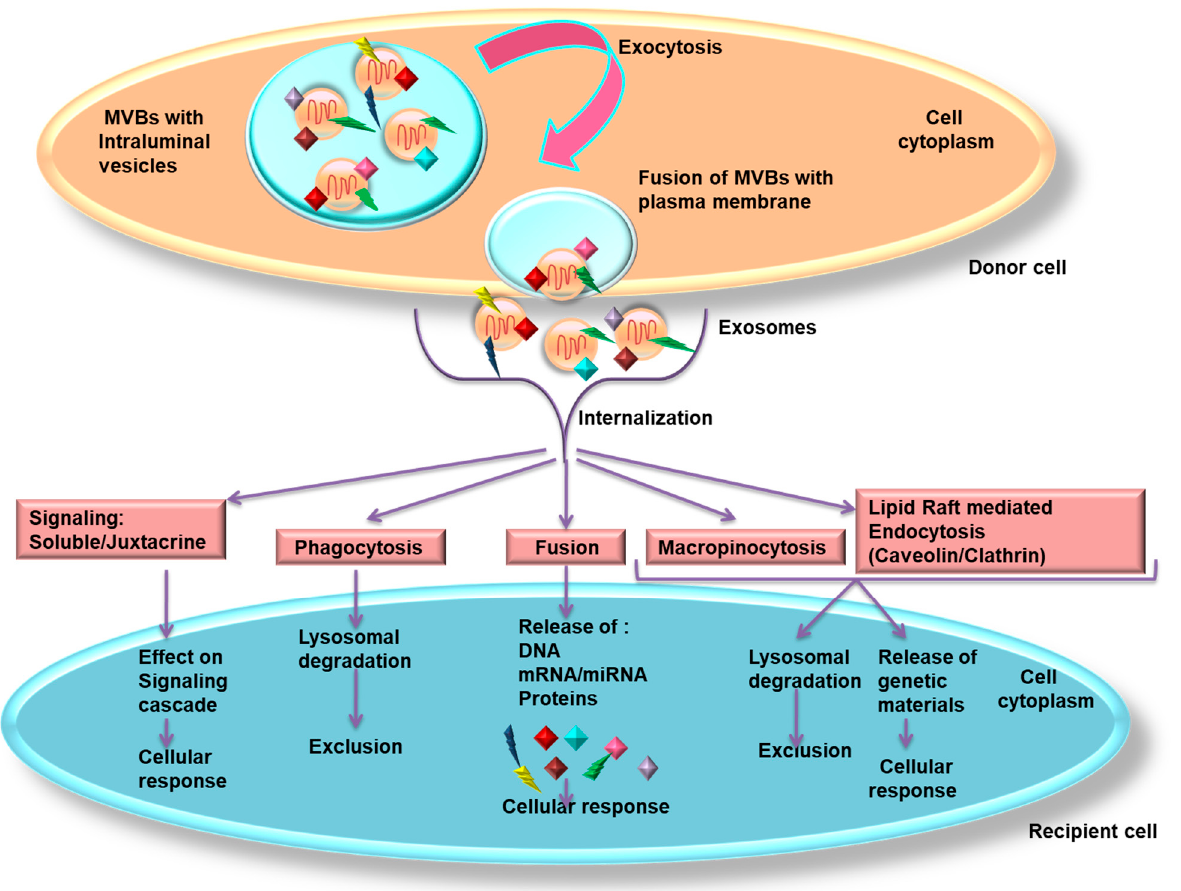
Figure 2. Mechanisms of internalization of exosomes. The exosomes inside the MVBs are extruded out from the donor cells by exocytosis on merging with plasma membrane. The released exosomes are then internalized via different modes: soluble/juxtacrine signaling; phagocytosis; fusion; micropinocytosis and lipid raft mediated endocytosis. The lipid raft mediated endocytosis can be either clathrin or caveolin protein dependent. Exosomes internalized by soluble/juxtacrine signaling affect the signaling cascade of the recipient cell. During phagocytosis, the exosomes undergo degradation, whereas, in the fusion event, genetic material is released that causes cellular response. In macropinocytosis and lipid raft-mediated endocytosis, the exosomes either undergo lysosomal degradation or mediate cellular response. Abbreviations: mRNA, messenger RNA; miRNA, microRNA; MVBs, multivesicular bodies.